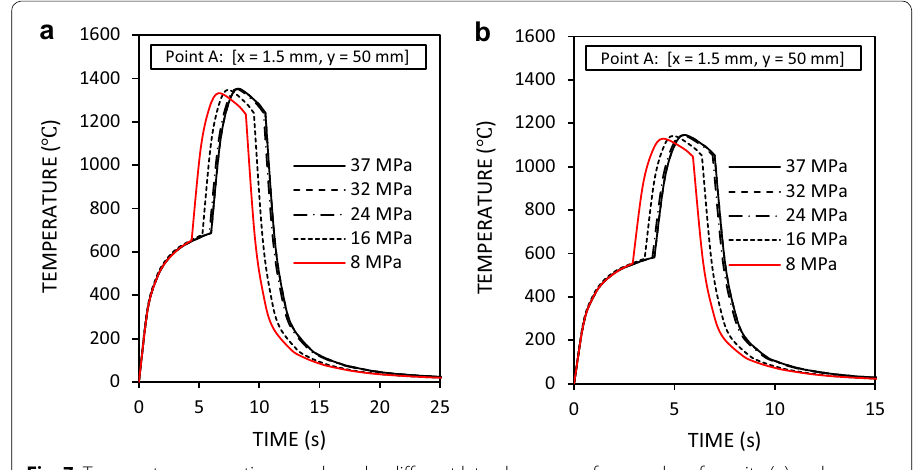
Fig. 7 Temperature versus time graph under different lateral pressures for samples of granite ( a ) and limestone ( b ) in point A